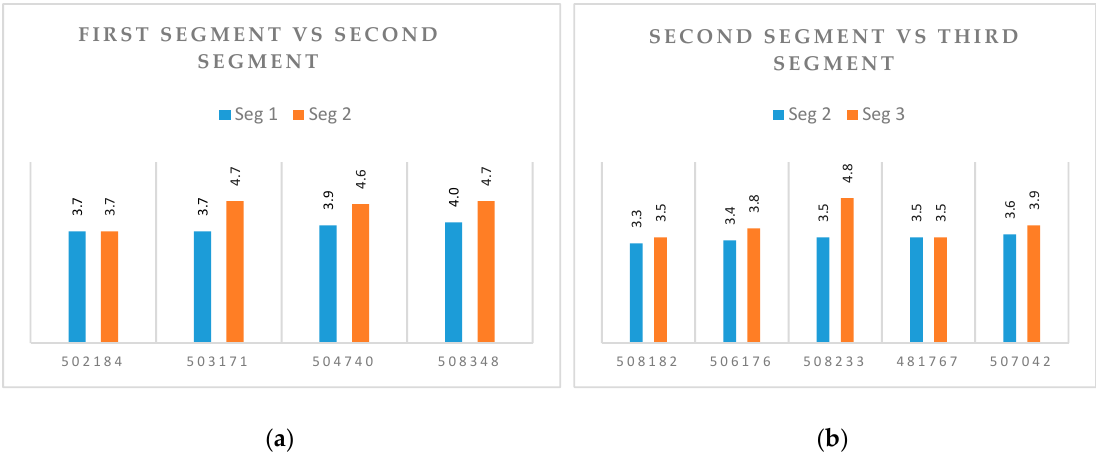
Figure 9. ( a ) The plotting for students’ grades in the first section versus the second. ( b ) The plotting for the same five students’ grades in the second segment versus the third.